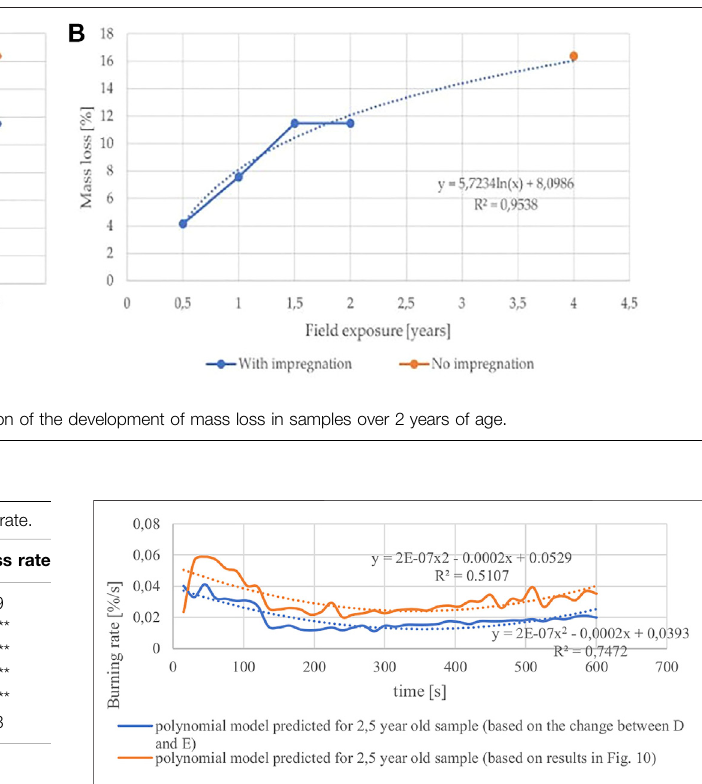
FIGURE 6 | Predicted development of the mass loss rate of the 2.5- year-old